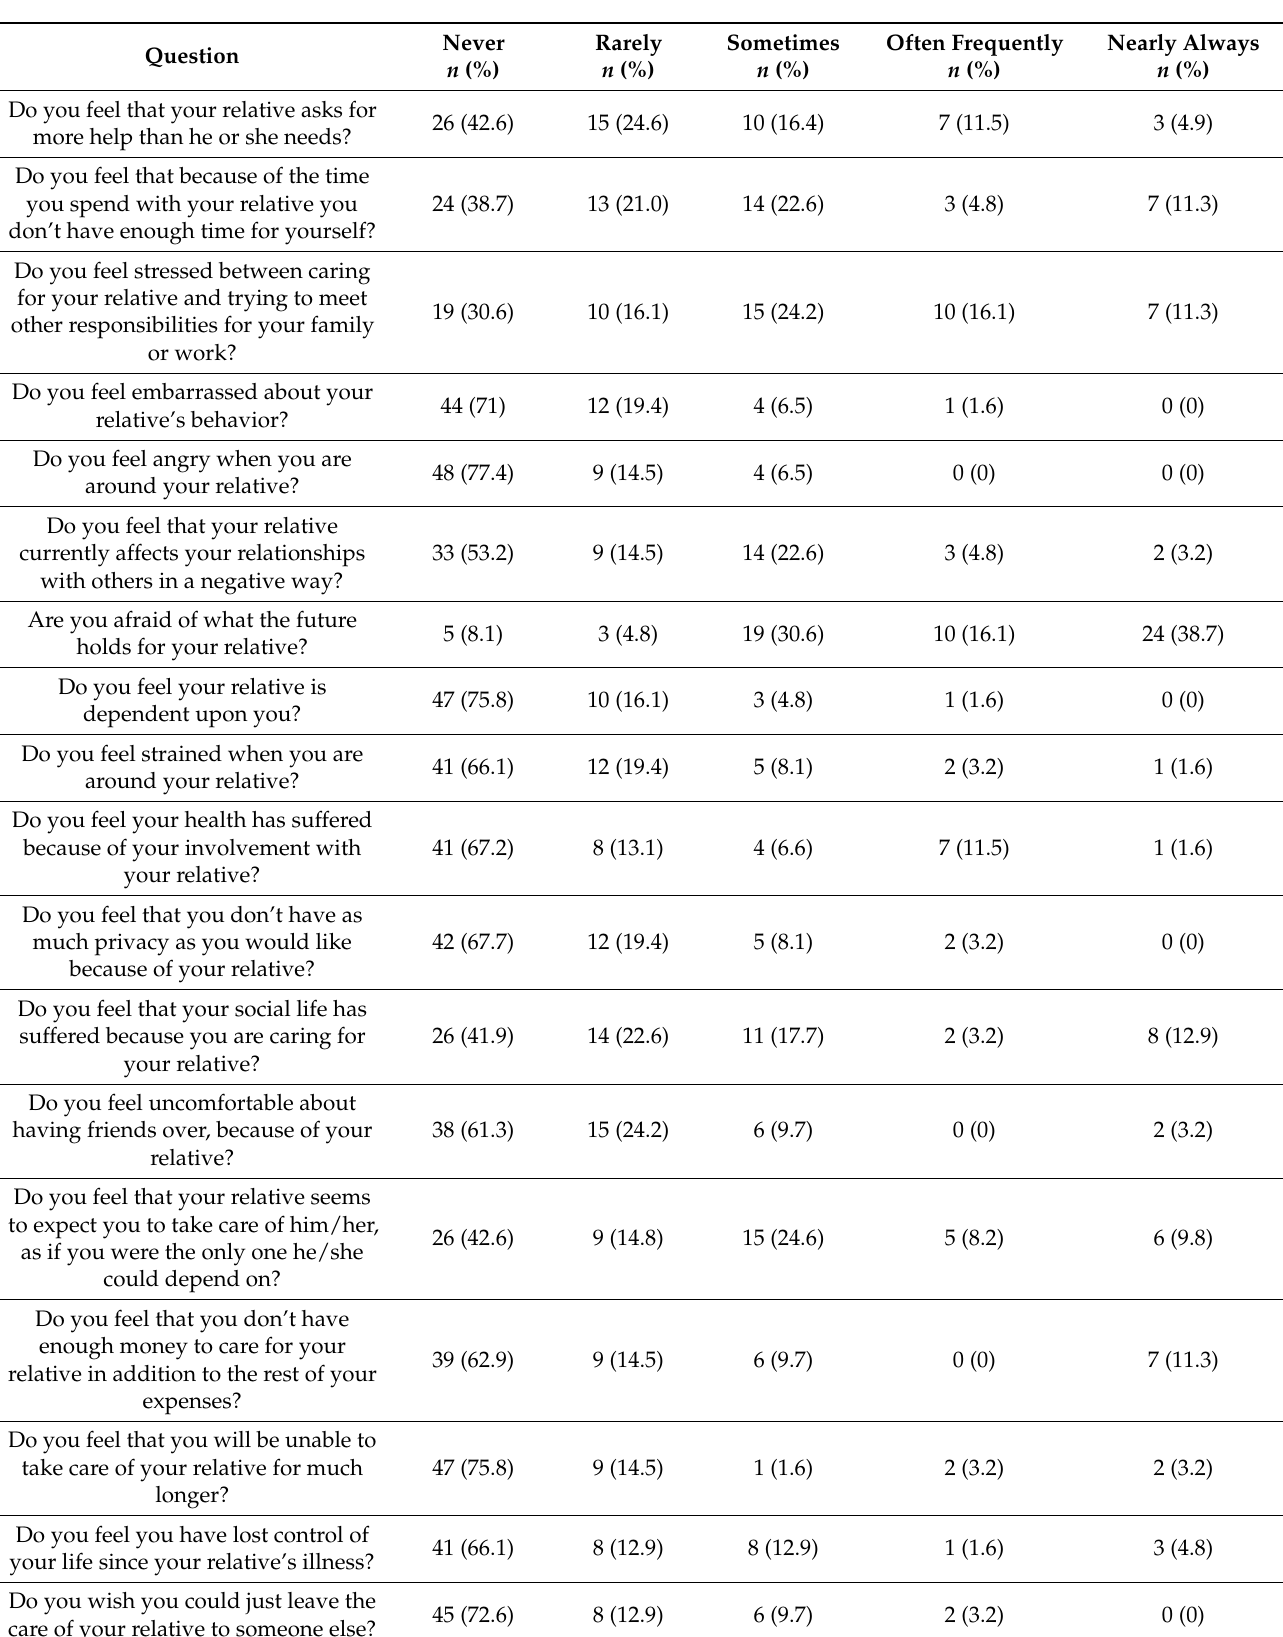
Table 2. Responses of caregivers to ZBI